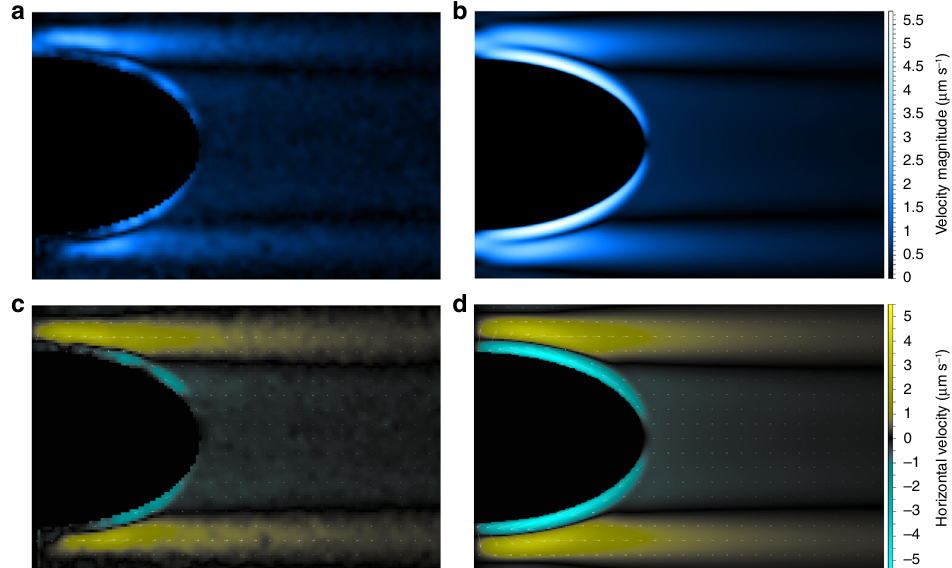
Fig. 4 Comparison of experiment with simulation. The fl ow fi eld in a vertical plane slicing the spheroid through north and south pole with Pe ¼ 52, μ ¼ 0 : 016 Poise, κ ¼ 1 : 5 ´ 10 (cid:3) 5 cm 2 s − 1 m, spheroid vertical radius, 0 : 5 cm, width, 2 cm, and with density gradient σ ¼ 0 : 002 g c − 4 . a Flow speed from PIV. b Flow speed from COMSOL. c Horizontal fl ow from PIV. d Horizontal fl ow from